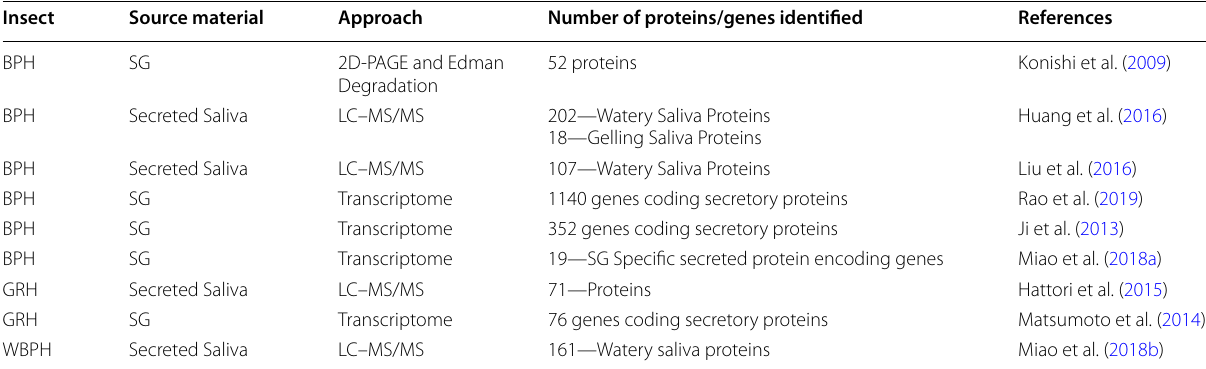
BPH Brown planthopper, GRH Green rice leafhopper, WBPH Whitebacked planthopper, LC MS / MS Liquid Chromatography–Tandem Mass Spectrometry , SG salivary gland, 2D-PAGE two-dimensional polyacrylamide gel electrophoresis